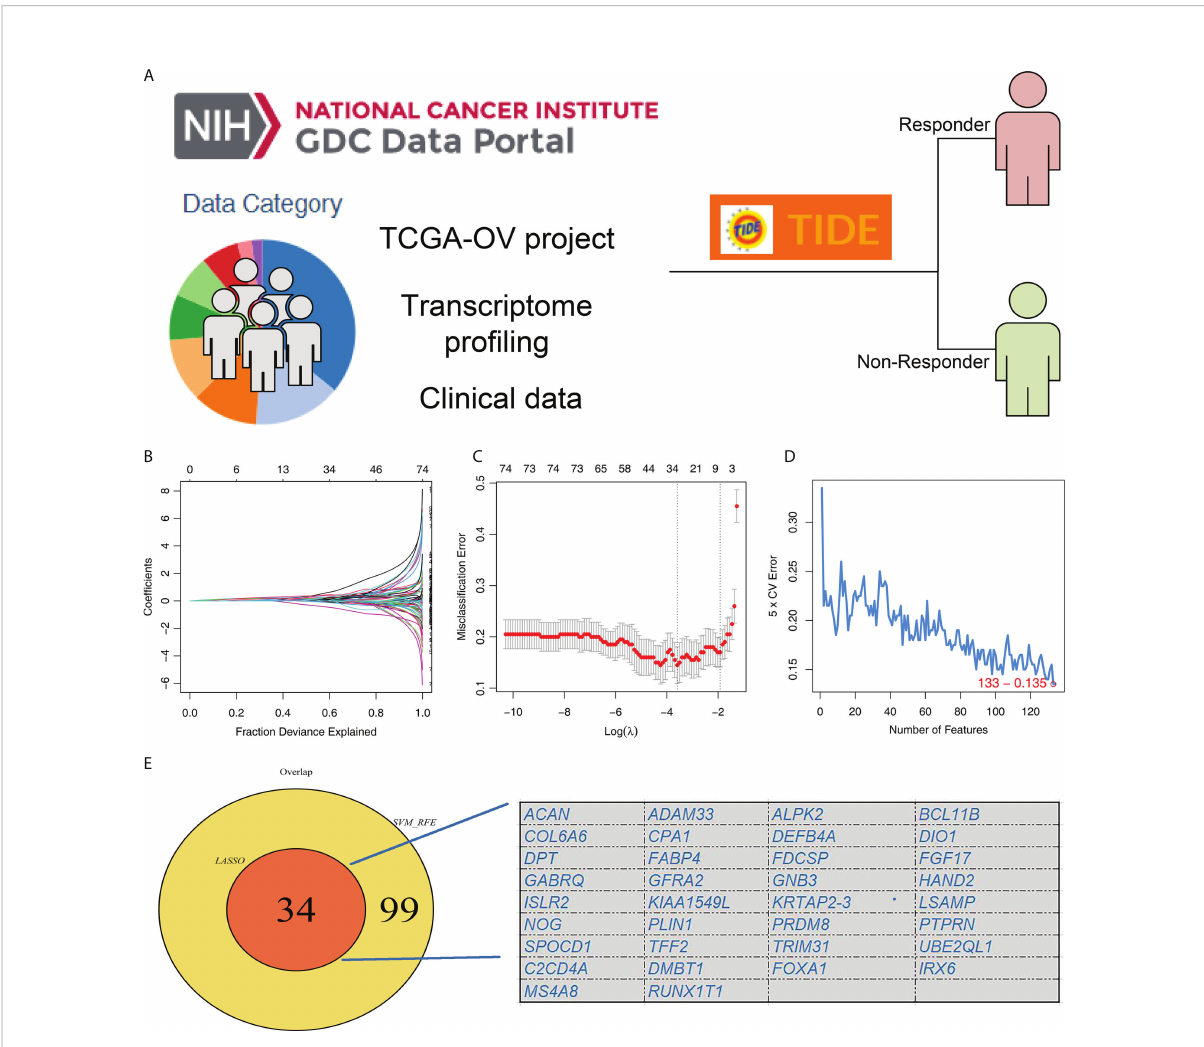
FIGURE 1 Identi fi cation of the characteristic gene of immunotherapy response. (A) TIDE analysis was performed to evaluate the immunotherapy response of TCGA-OC patients, in which TIDE > 0 were de fi ned as immunotherapy non-responder and < 0 were de fi ned as immunotherapy responders; (B, C) LASSO logistic regression algorithm; (D) SVM-RFE algorithm; (E) LASSO logistic regression and SVM-RFE algorithms identi fi ed 34 characteristic